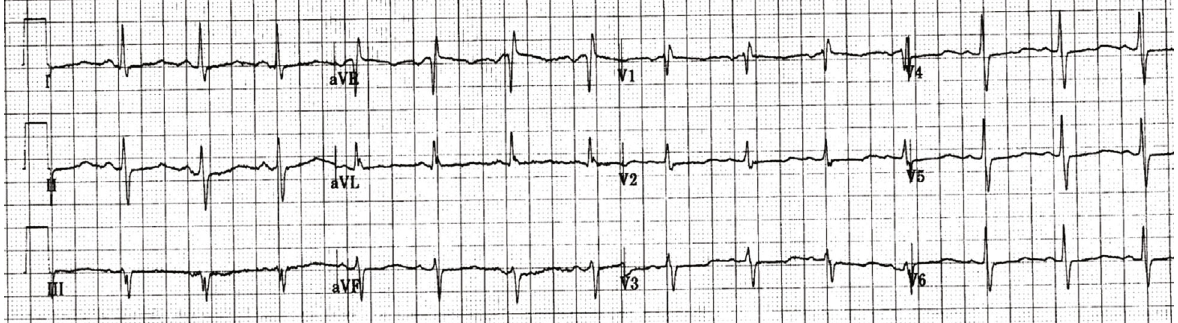
Figure 3: Electrocardiogram showing normal sinus rhythm with bifascicular block (right bundle branch block and left anterior fascicular block).